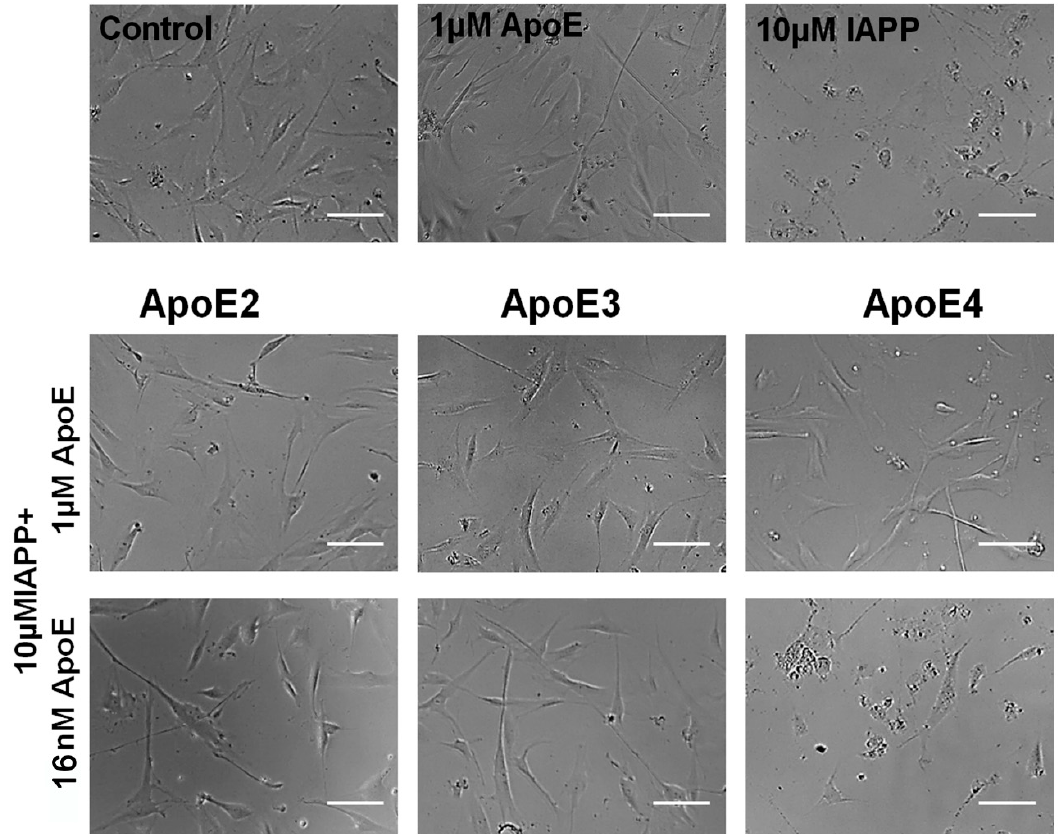
Figure 5. Morphology of the pericytes imaged under the phase-contrast microscope after 72 h treatment (scale bar is 100 µ m). The upper panel represents controls (untreated cells) and cells treated with 1 µ M ApoE only (here is the representative image from sample treated with ApoE4) and 10 µ M IAPP only. Below are the images of the cells treated with 1 µ M IAPP in combination with the indicated ApoE variants at the highest (1 µ M) and the lowest (16 nM) concentrations used in the experiment.